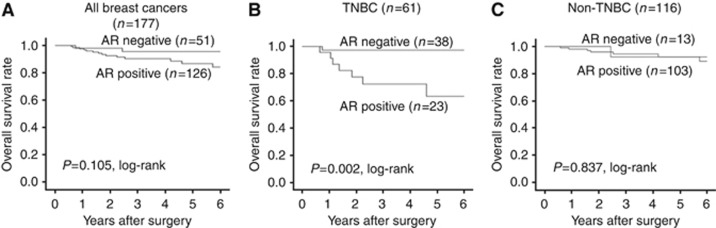
Analysis of overall survival (OS) revealed similar observations according to the subtypes and AR expression status of the breast cancer (A–C).